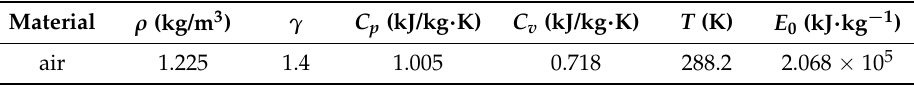
Table 3. Material properties of